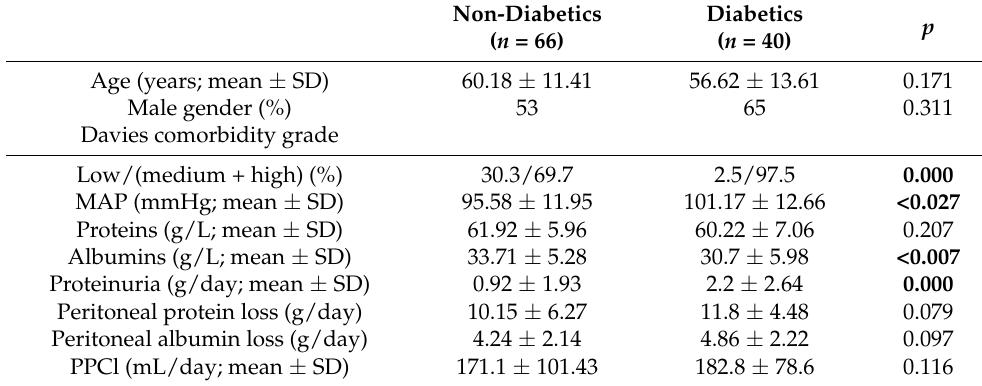
Table 1. Baseline patient characteristics according to presence of diabetes mellitus.